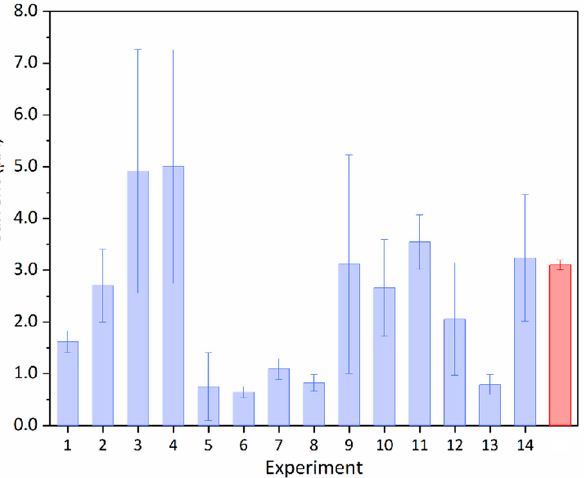
Figure 5. Design of Experiment: ( a , c ) coefficients of the model obtained with aGCE ( a ) and aSPCE ( c ) (significance level = 0.05; * = p ≤ 0.05; ** = p ≤ 0.01; *** = p ≤ 0.001); ( b , d ) response surfaces obtained with SC 25 mV s − 1 with aGCE ( b ) and aSPCE ( d ). E p = E pulse ; t p = t pulse .